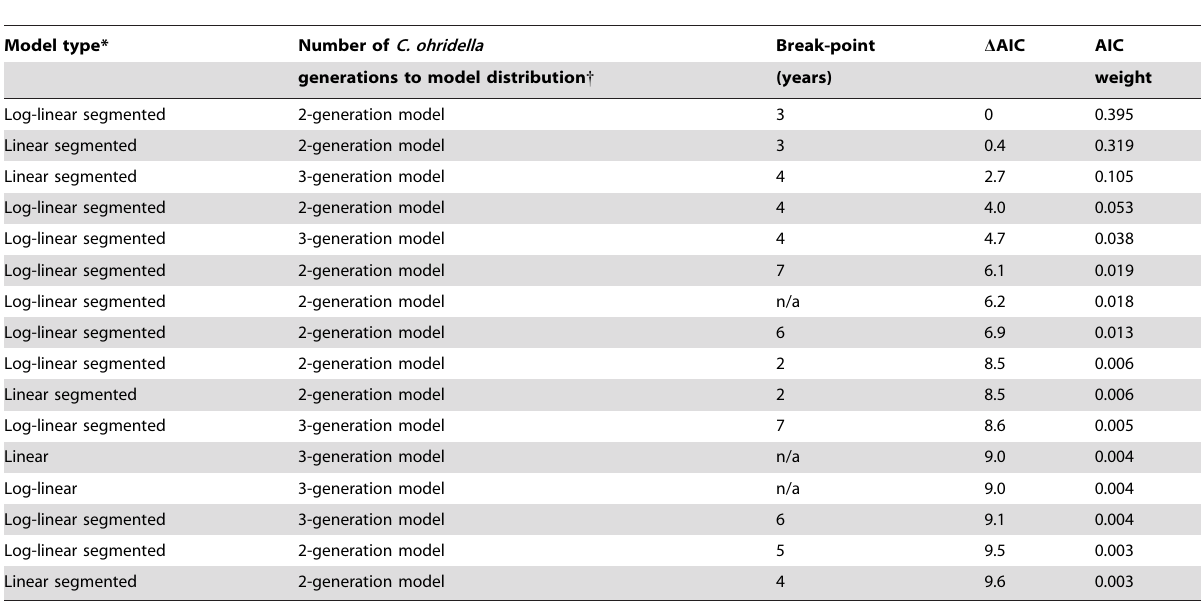
Table 2. The top-ranked set of ordinal regression models relating leaf damage of A. hippocastanum with the number of years that C. ohridella was predicted to have been present.